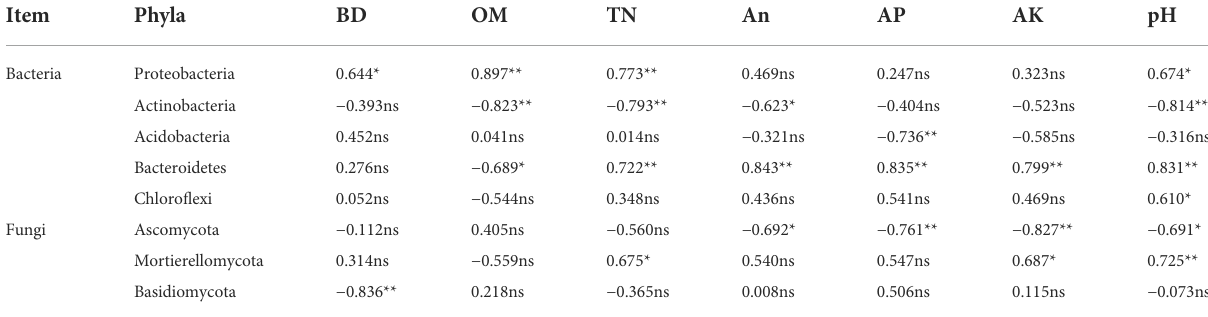
TABLE 5 Correlation analysis of the dominant soil microbial phyla and soil environmental factors after 16 years (2004 – 2019).